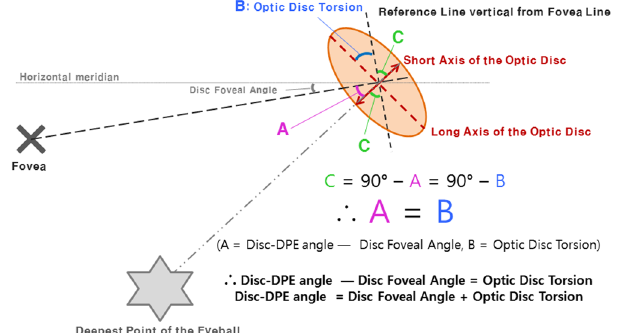
Figure 7. Geometric calculation on the degree of the angle of the the Disc-DPE angle as the sum of the degree of optic disc torsion and the disc foveal